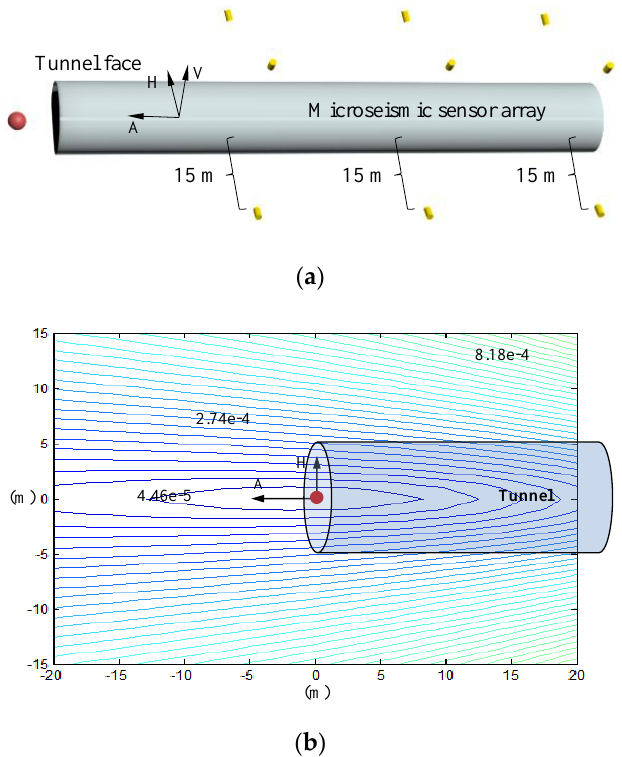
Figure 5. Lateral-extended array and residual space: ( a ) lateral-extended array placement; ( b ) residual space in the A-H plane, and the maximum value of the residual variation rate is 8.18 × 10 − 4 , and the residual space effect also exits in the axial direction.